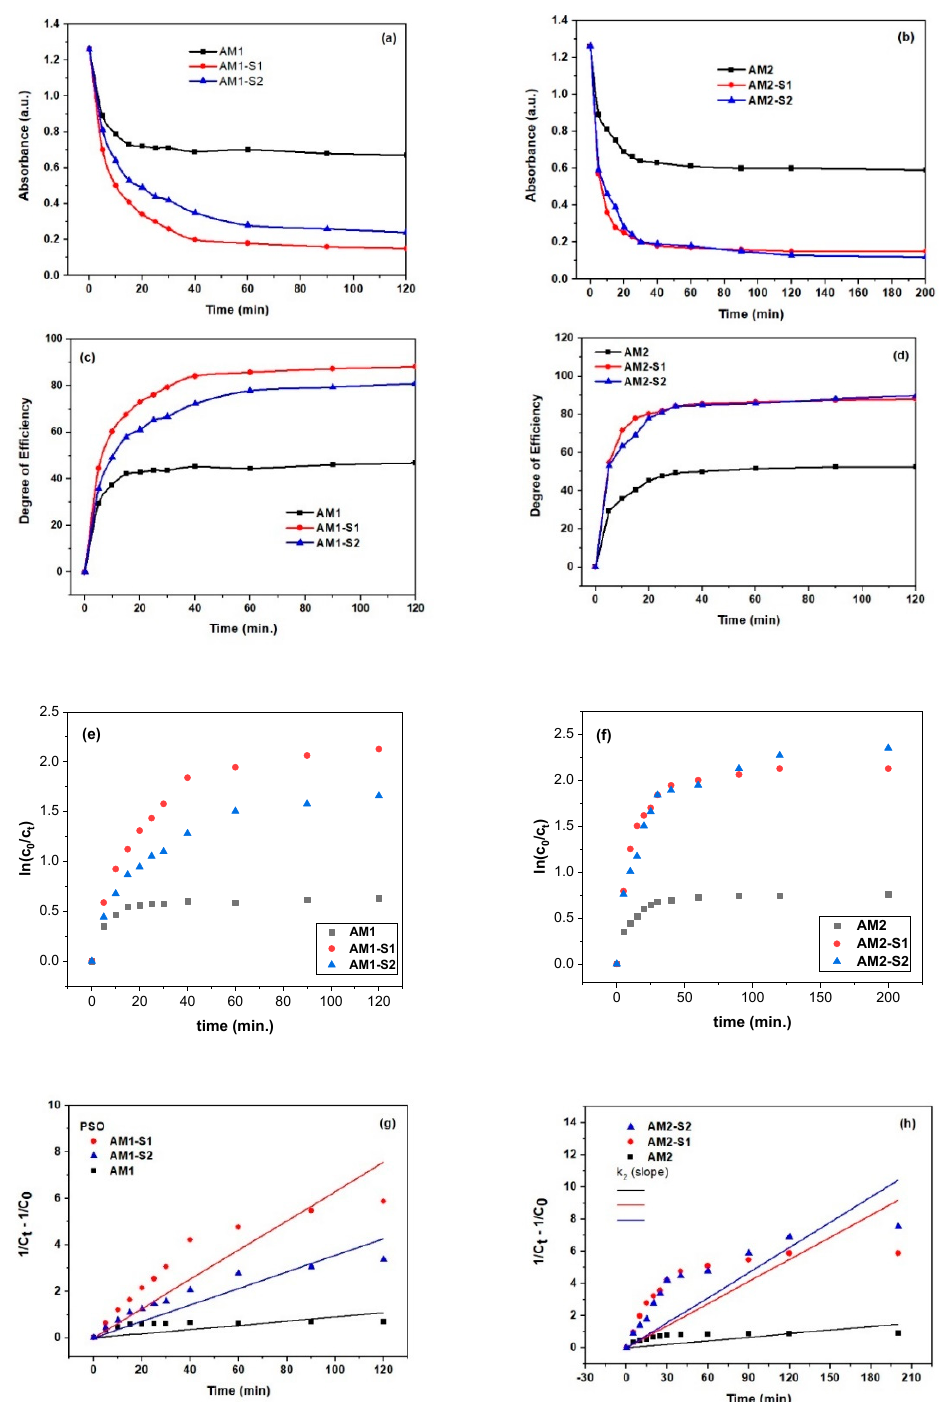
Figure 9. Photocatalytic degradation of MB on Ag-decorated AM1, AM2, and AM(1/2)-S(1/2) nanocatalysts via UV–Vis spectrophotometry ( a , b ), MB discoloration efficiency ( c , d ), photodegradation kinetics: PFO ( e , f ) and PSO ( g , h ) (c(MB) = 5 mg/L, V = 25 mL of MB solution and w(AM(1/2)-S(1/2) = 0.040 g at room temperature). Table 3. Kinetical parameters for the 120 min. photocatalysis process of MB degradation under UV irradiation and kinetical models [80].